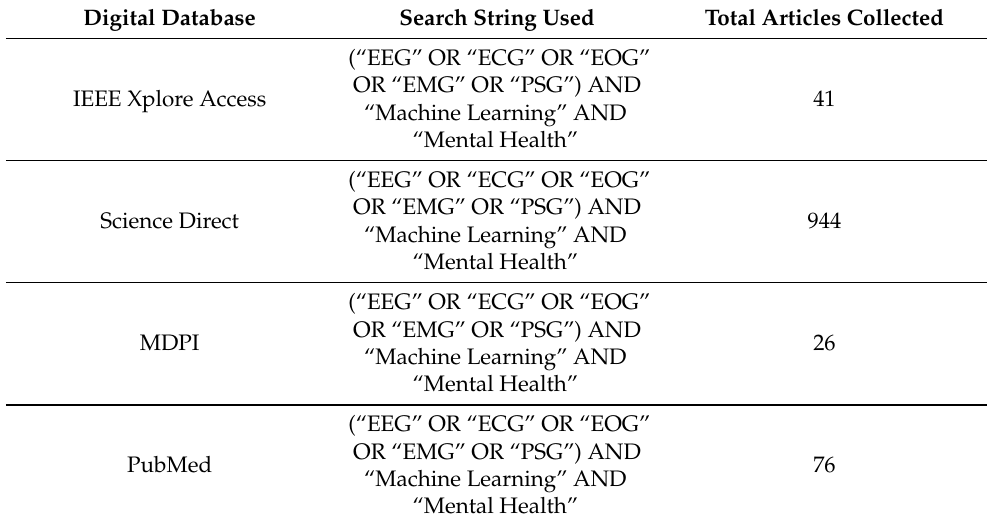
Table 1. A summary of search criteria and results from the different digital